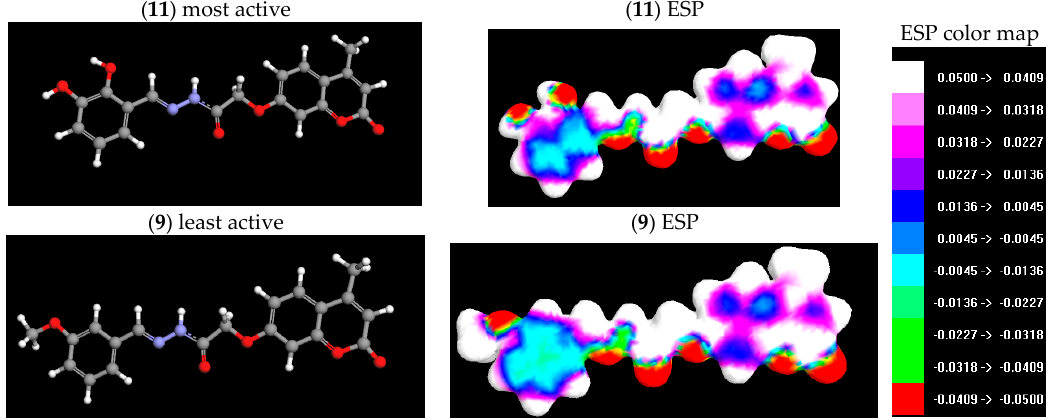
Figure 3. Three-dimensional optimized structure (MM+, AM1) and electrostatic potential (ESP) surface maps of the most active compound ( 11 ) and the least active compound ( 9 ).